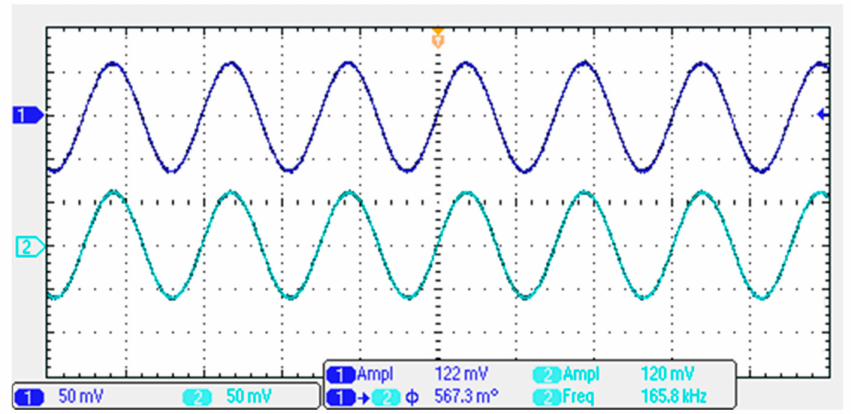
Figure 35. The measured time domain input and output voltage waveforms of the NBPF at the output of V BP5